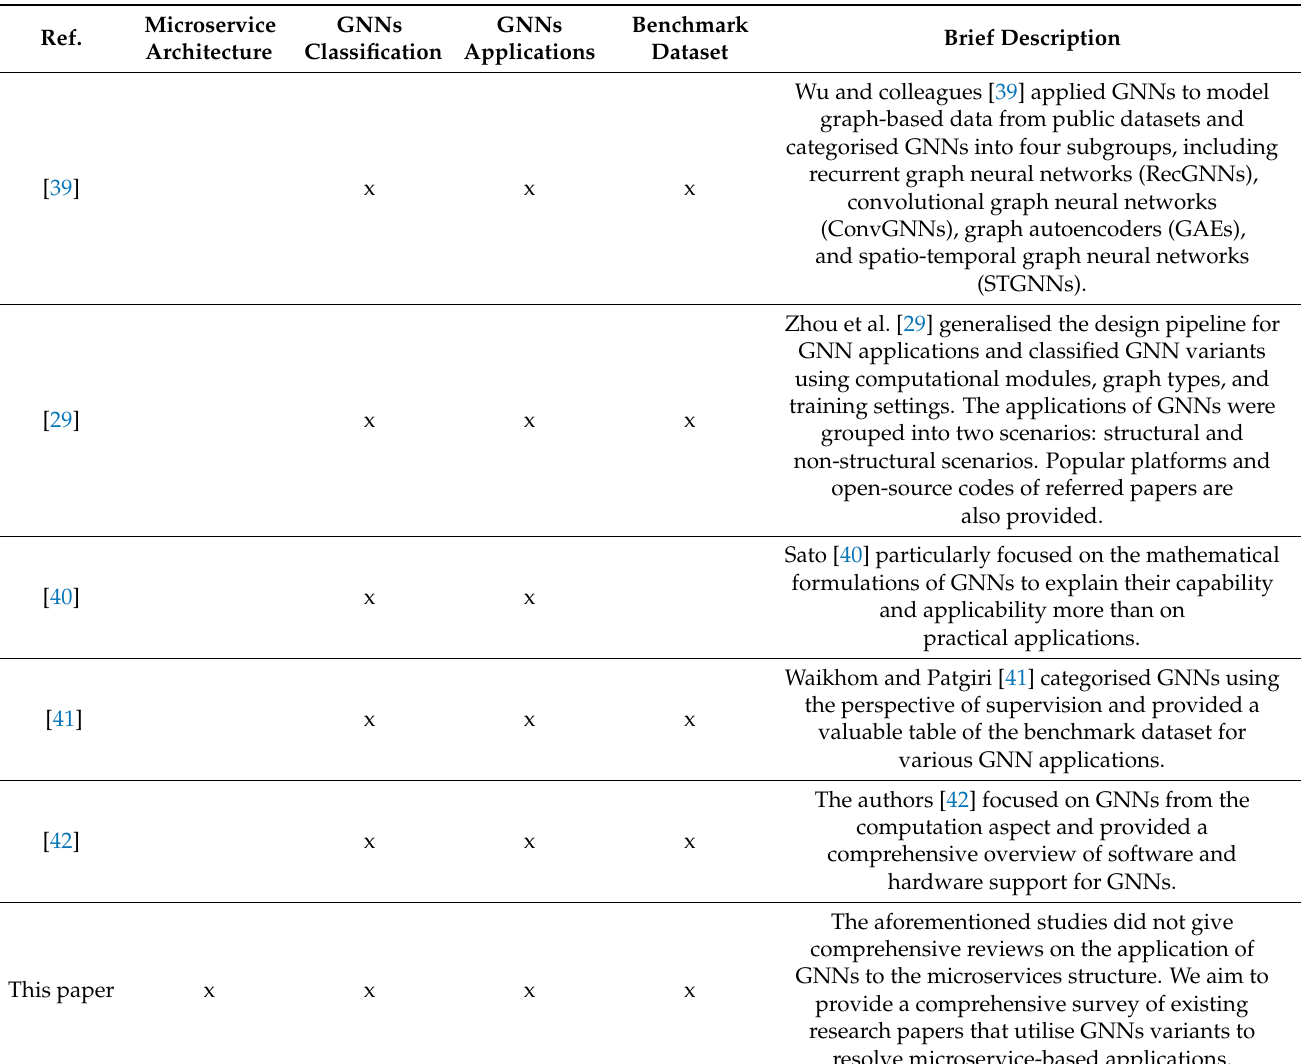
Table 1. Summary of recent related